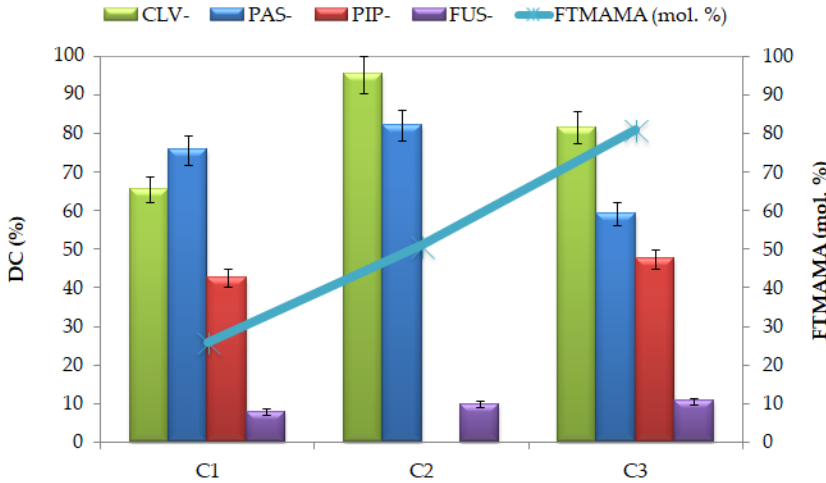
Figure 4. Effect of anion type and content of ionic fractions on the drug content.